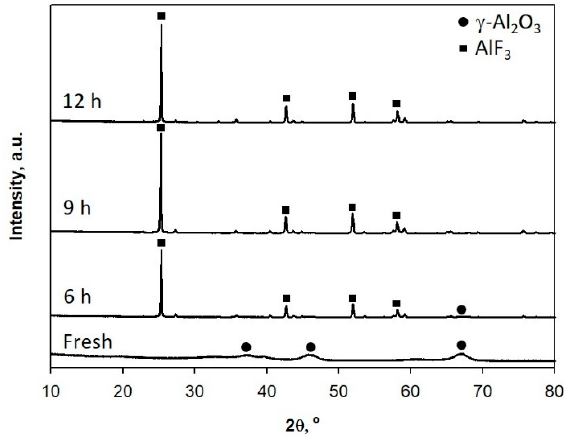
Figure 5. XRD results of fresh and spent γ -Al 2 O 3 used in SB- γ -Al 2 O 3 -0.6.